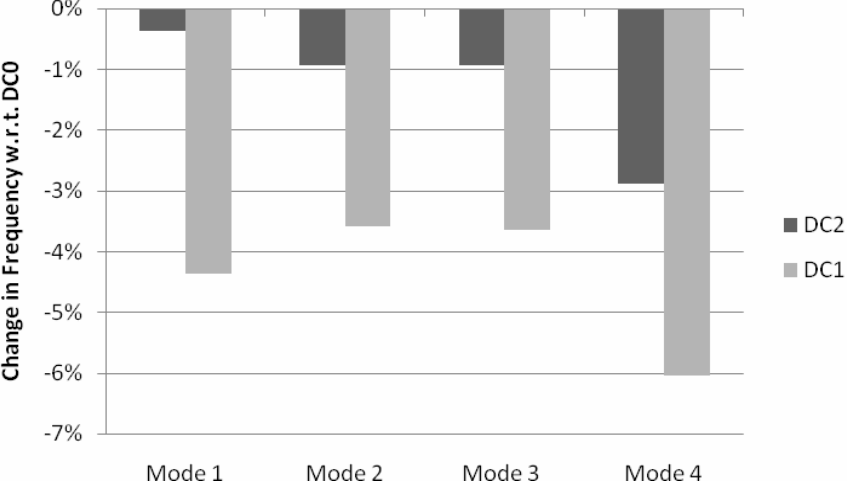
Fig. 13. Change in identified modal frequencies due to damage